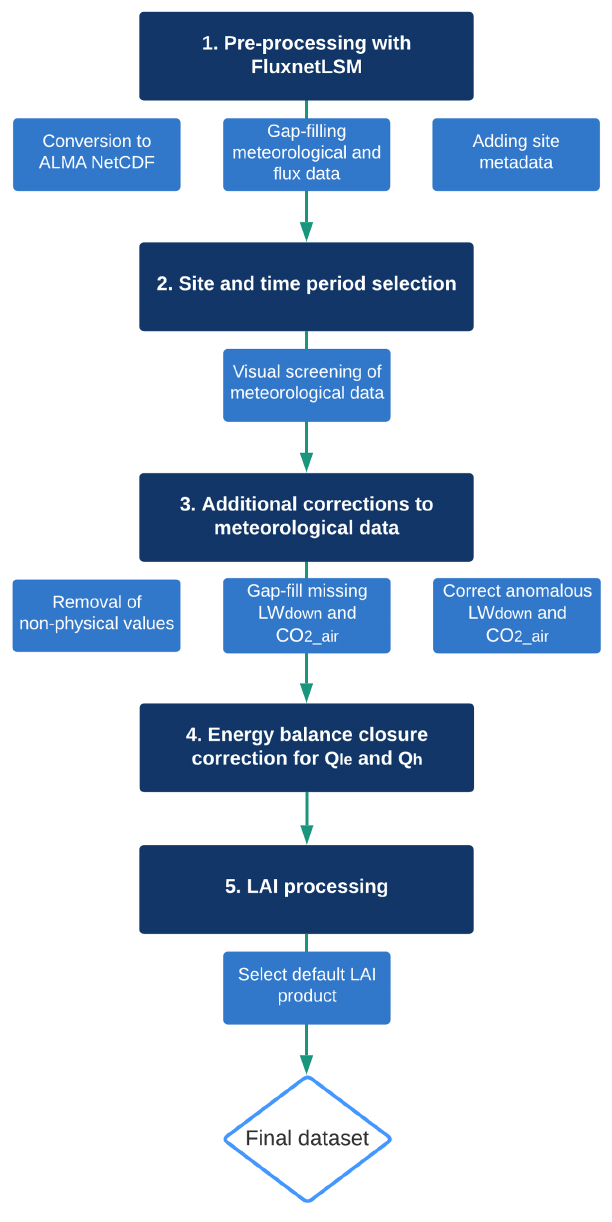
Figure 1. A flowchart describing the data processing pipeline. The dark boxes show the main data processing steps, with the lighter boxes detailing the actions taken within each main